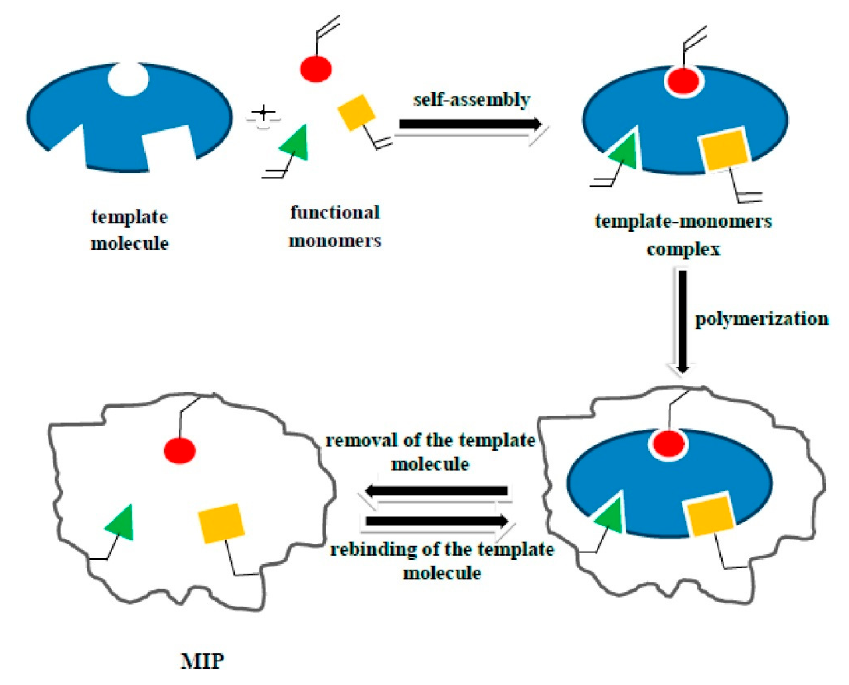
Figure 2. General scheme for molecular imprinting (figure adapted from [64]).